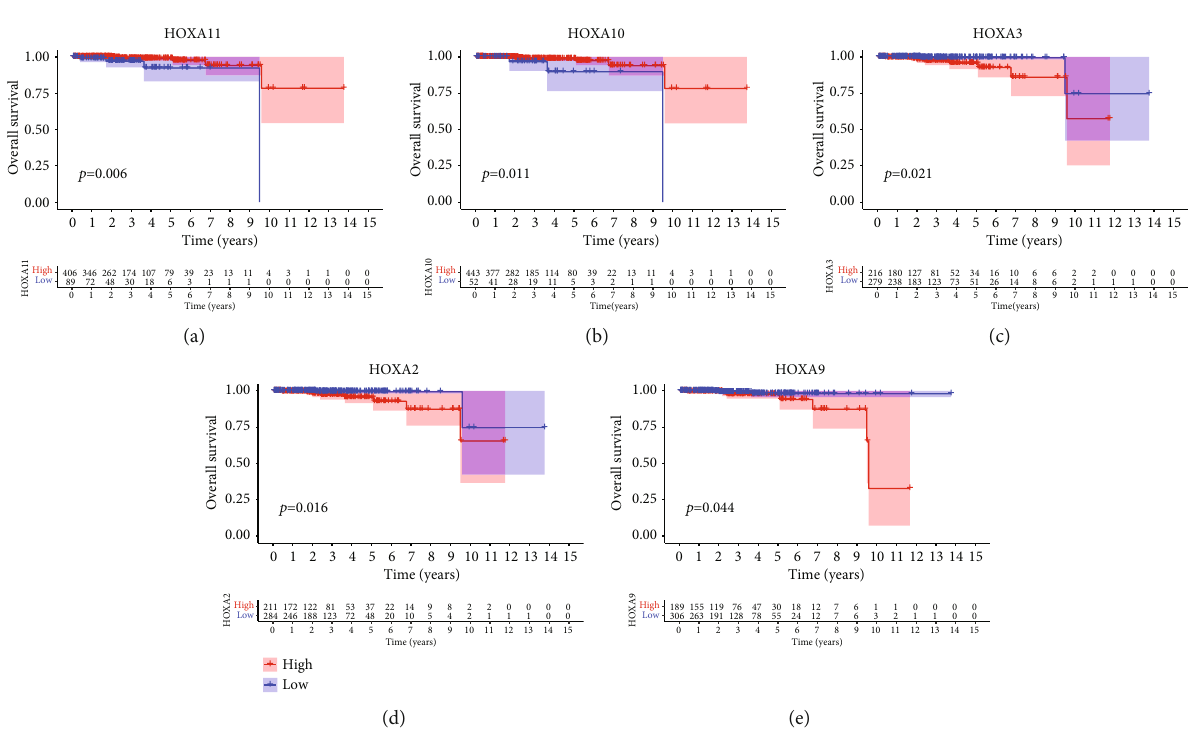
Figure 6: K-M curves for the OS of su ff erers in the high and low groups based on the mean expression of (a) HOXA11, (b) HOXA10, (c) HOXA3, (d) HOXA2, and (e) HOXA9 in TCGA cohort.